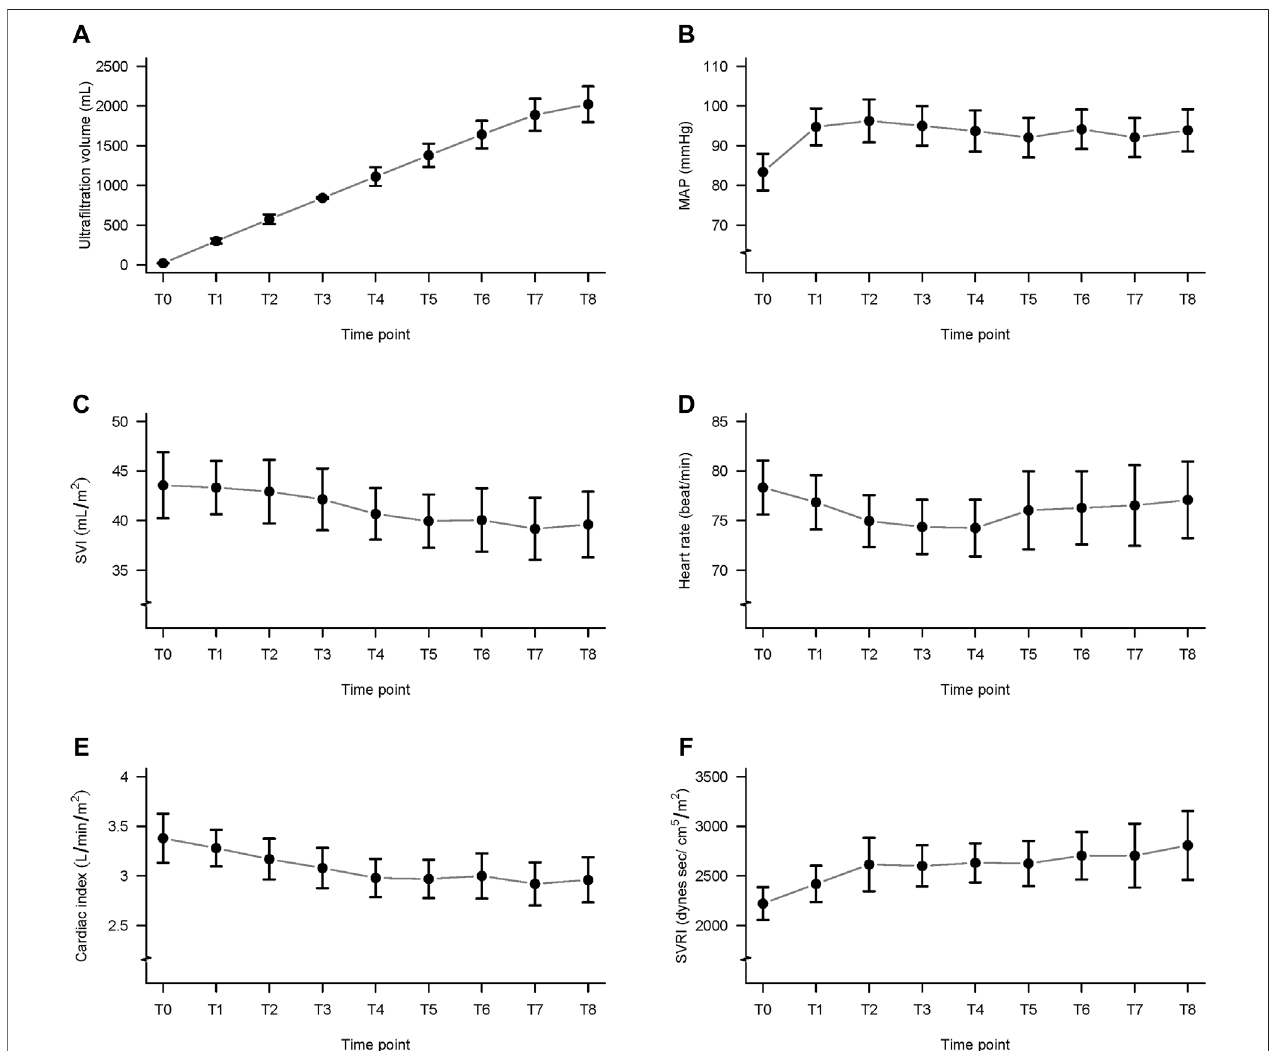
FIGURE1| Ultra fi ltration volume anddata fromtheClearSightmonitoringsystem,during hemodialysis. (A) Ultra fi ltration volume; (B) meanarterialpressure(MAP); (C) stroke volume index (SVI); (D) heart rate (HR); (E) cardiac index (CI); and (F) systemic vascular resistance index (SVRI); T0 to T8: from before hemodialysis (T0) to 240 min (T8) in 30-min